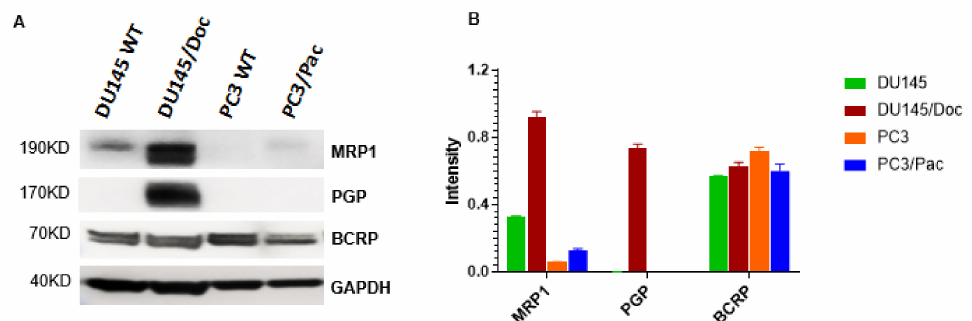
Figure 1. ATP-Binding Cassette Transporter Protein Expression (MRP1, PGP, BCRP) in wild-type and taxane-resistant prostate cancer cells. ( A ) Western blot. Thirty-five ug total protein samples were loaded per lane. The uncropped blots are shown in Figure S3. ( B ) Densitometry. Summary of results from three independent Western